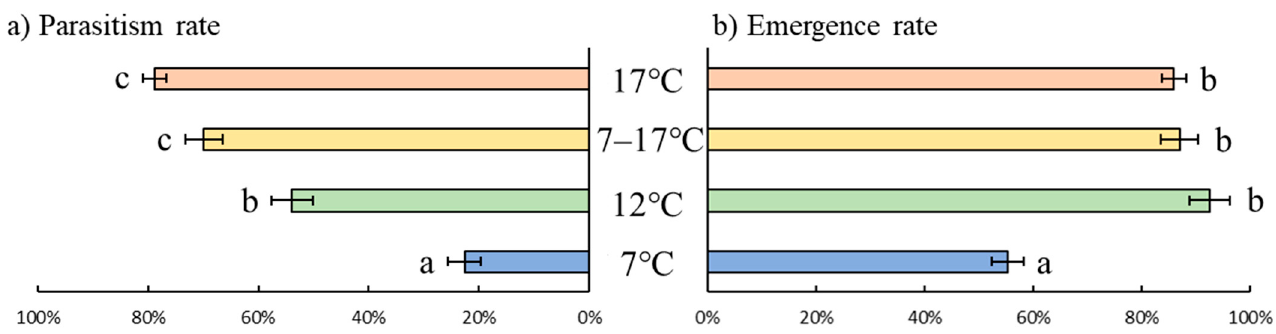
Figure 1. Parasitism rates ( a ) and emergence rates ( b ) of Aphidius matricariae parasitoids reared on Dysaphis plantaginea at three constant temperature regimes (7 °C, 12 °C, and 17 °C) and one fluctuating temperature regime (7–17 °C). Lowerscript letters indicate significant differences ( p < 0.05) among temperature regimes for each measured parameter. N = 10.